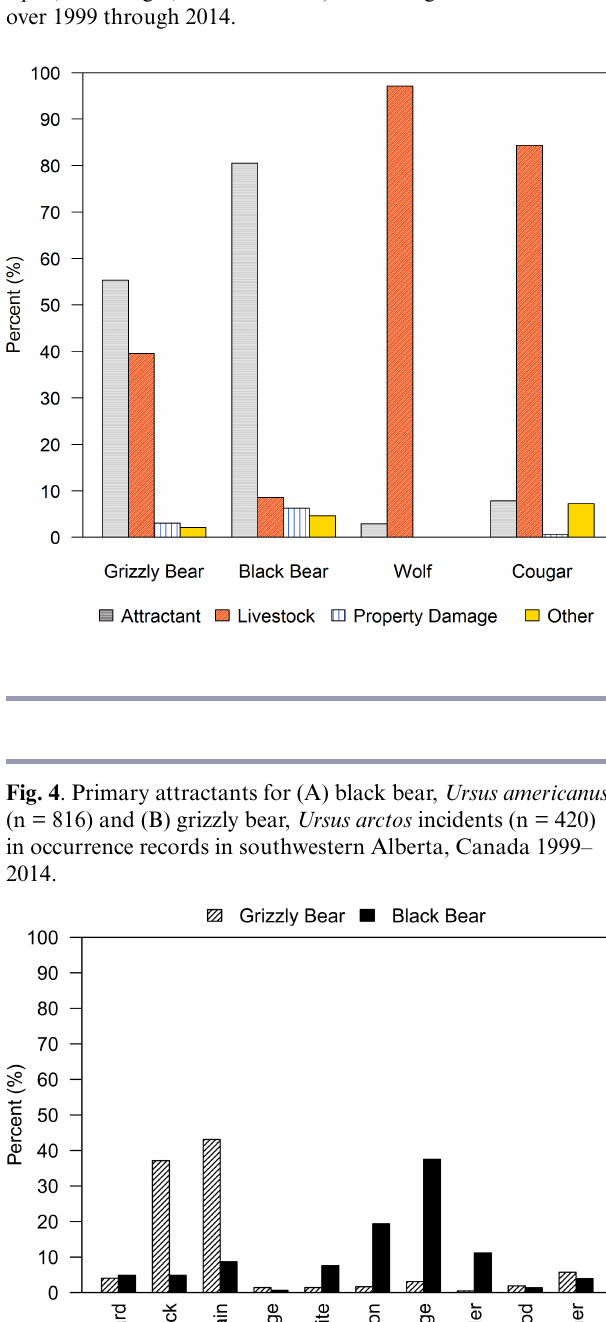
Fig. 3 . Large carnivore incidents by species and type (grizzly bear, Ursus arctos ; black bear, Ursus americanus ; wolf, Canis lupus ; and cougar, Puma concolor ). Percentages are cumulative over 1999 through 2014.